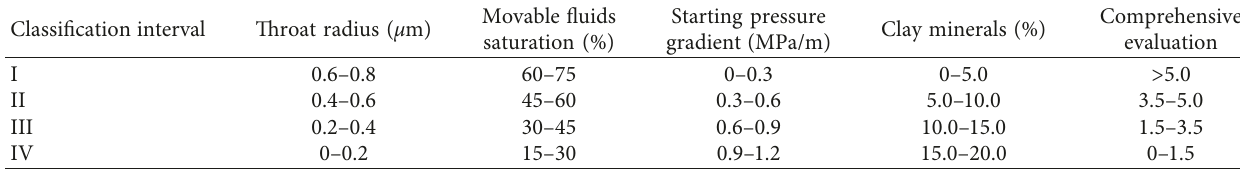
Table 3: Longitudinal evaluation interval of tight